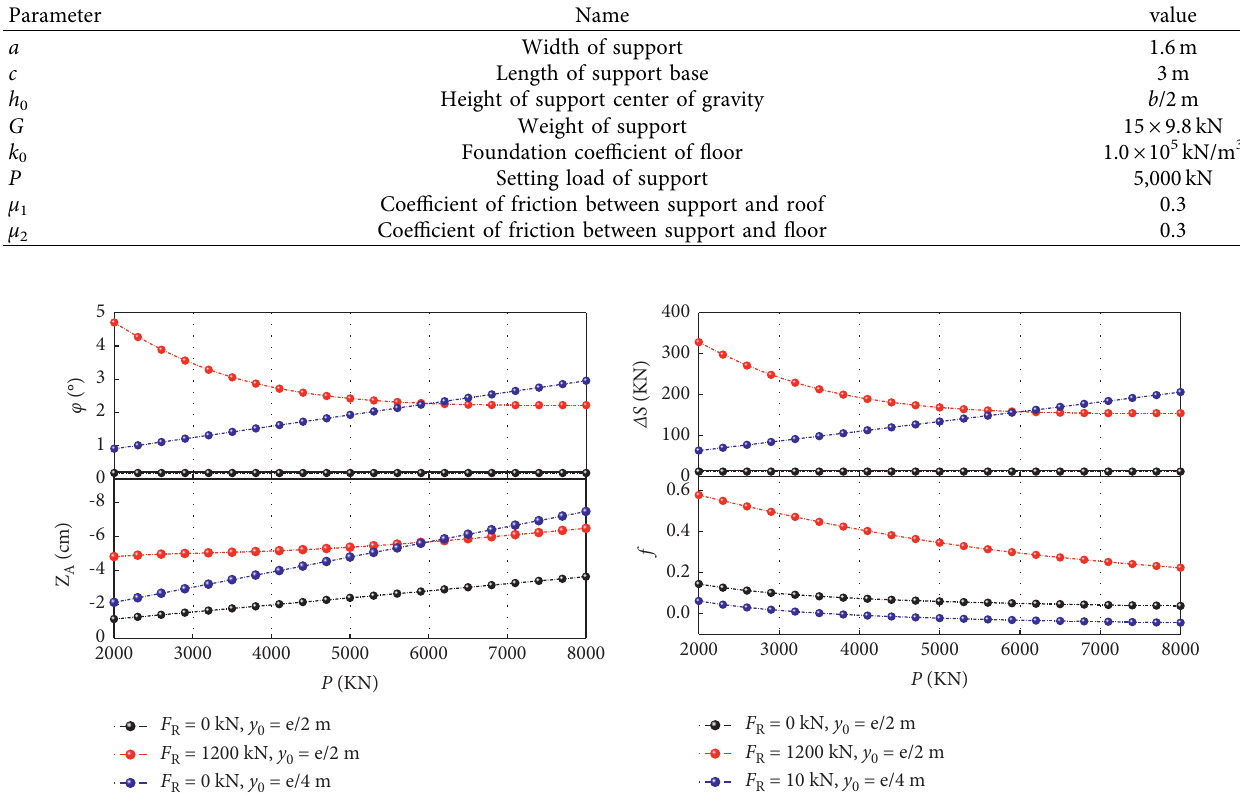
Table 2: Physical parameters used in the model.